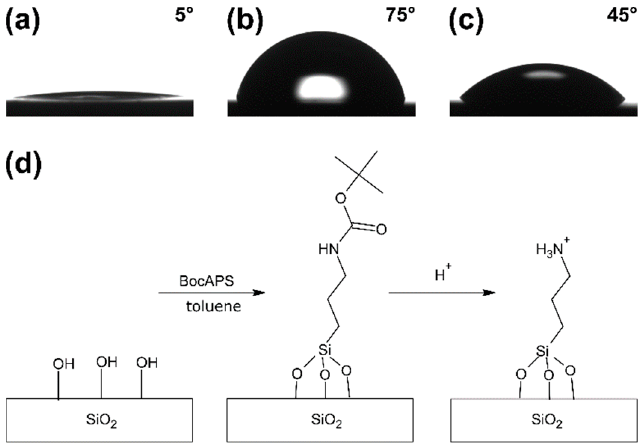
Figure 3. Water-drop profiles on the bare SiO 2 surface (after clearing with UV–ozone) ( a ), BocAPS-modified SiO 2 surface ( b ), and BocAPS-modified SiO 2 surface after removing the Boc groups ( c ). Scheme of self-assembled monolayer (SAM) formation and removal of the protective group ( d ).